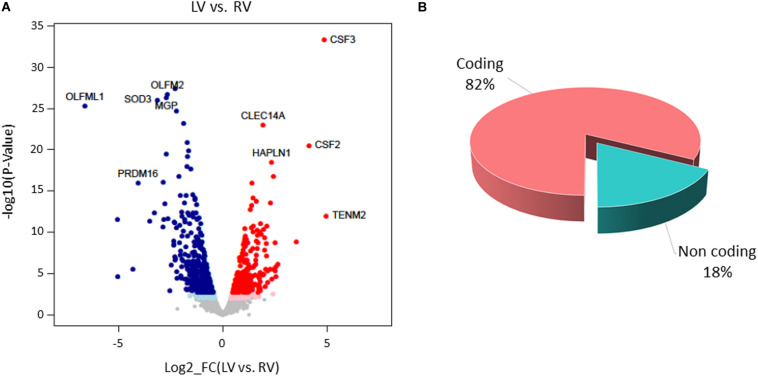
Differential gene expression between left ventricle (LV) and right ventricle (RV) cardiac mesenchymal stromal cells (C-MSC). (A) Scatterplot of the log2 fold change (FC) vs. the significance (x- and y-axes, respectively) for the paired comparison of LV vs. RV C-MSC. Red and blue dots represent genes overexpressed in LV and RV C-MSC, respectively. Light red and light blue dots are genes significant at the nominal P-value < 0.01, whereas red and blue dots represent significant differentially expressed (DE) genes that withstood adjustment for multiple testing (adjusted P-value < 0.05). Ten of the top DE genes with the highest combined rank score (the product of the log2 FC × likelihood ratio) are shown. (B) Pie chart of the percentage of coding (pink) and non-coding (light blue) differentially expressed genes; more than 80% of DE genes are protein coding.